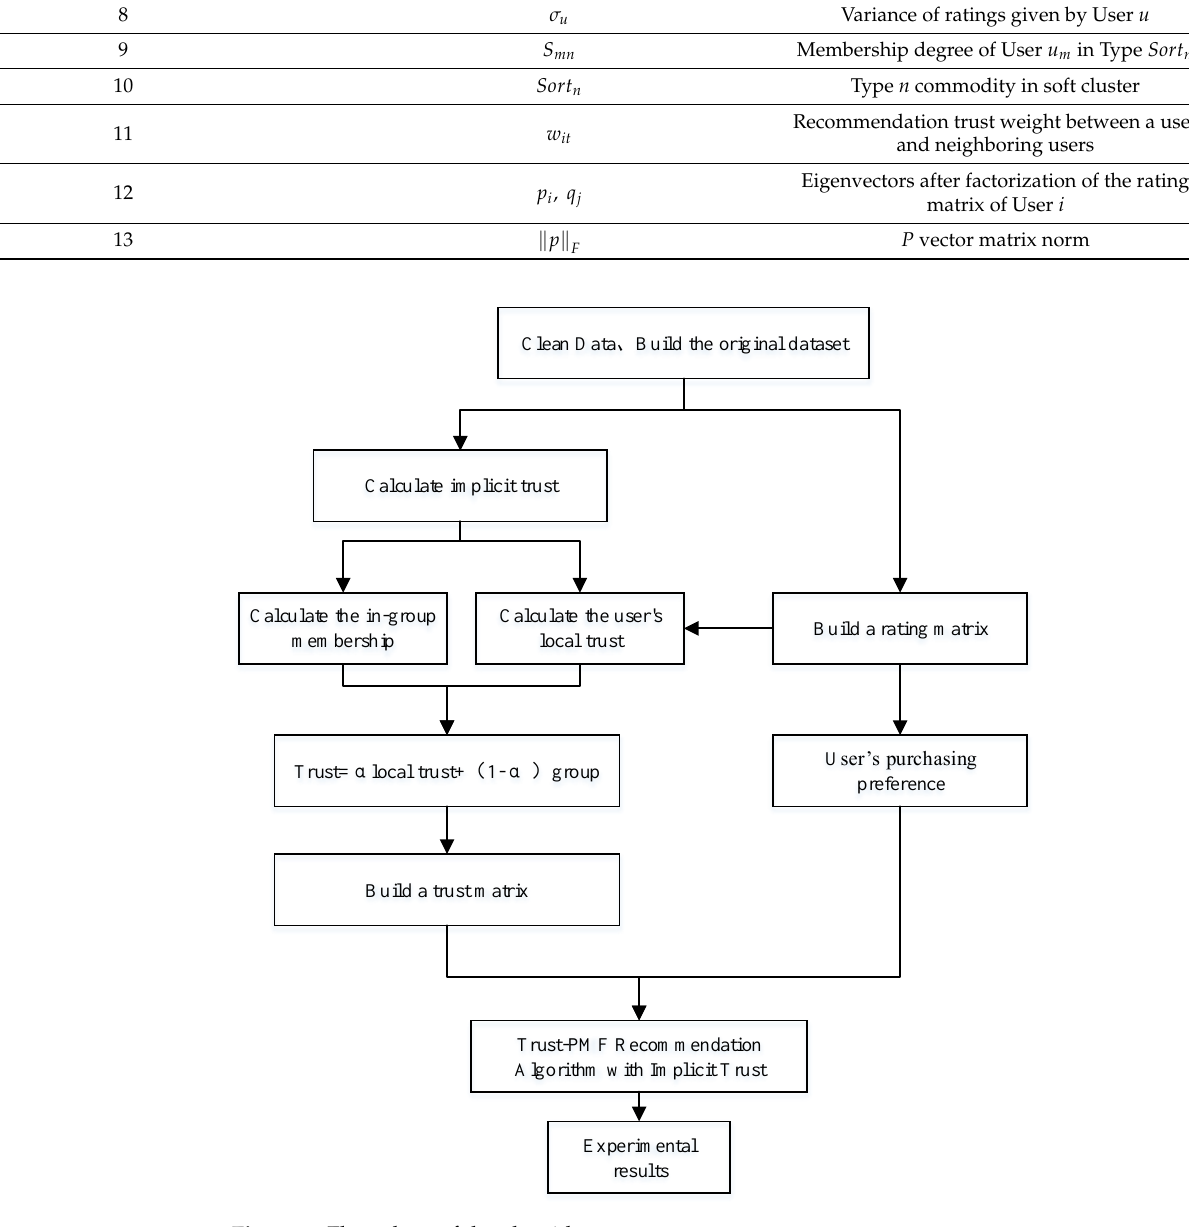
tion. Table 1. Symbols used in formulas and their description.